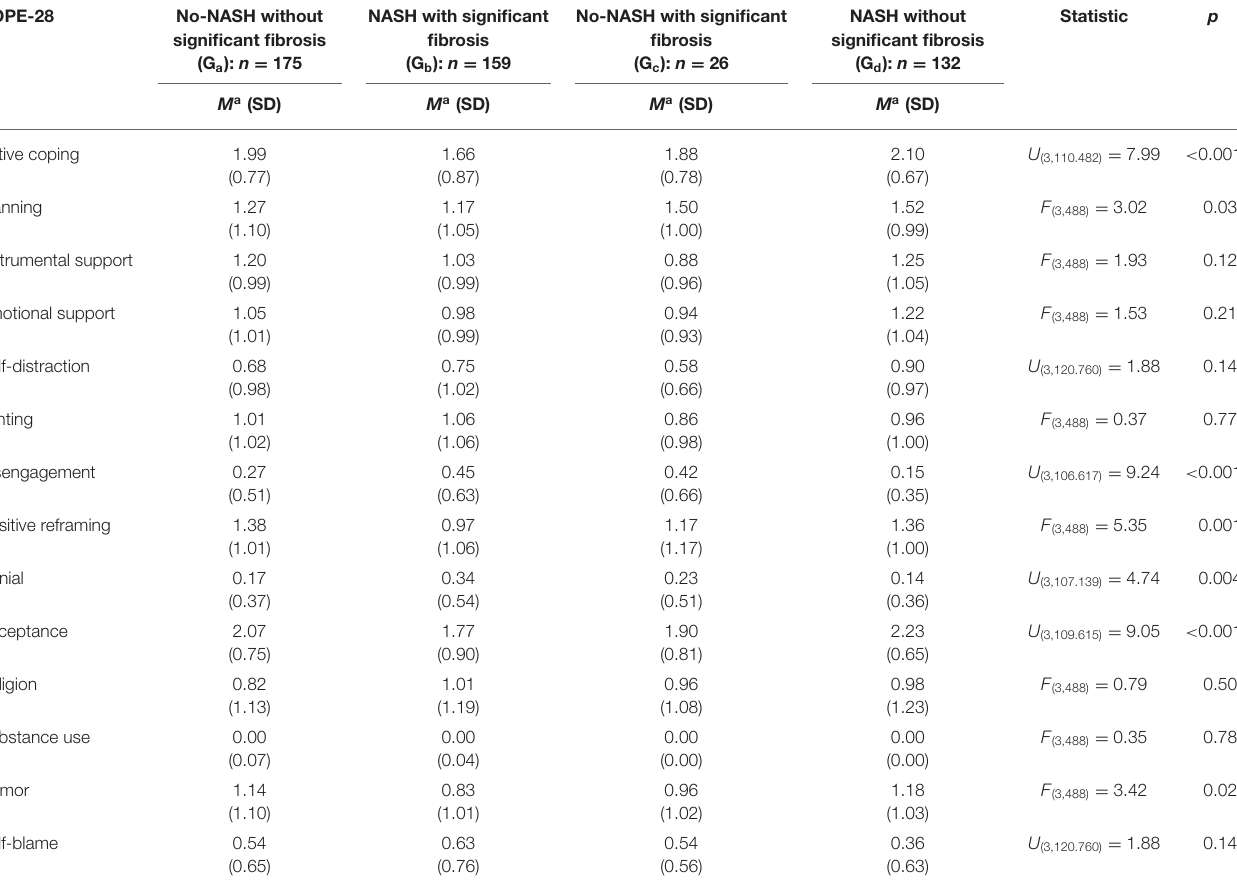
TABLE 9 | Comparison of coping strategies (COPE-28) between non-alcoholic fatty liver disease (NAFLD) severity groups: non-alcoholic steatohepatitis (NASH; with and without significant fibrosis) and no-NASH (with and without significant fibrosis). COPE-28 No-NASH without significant